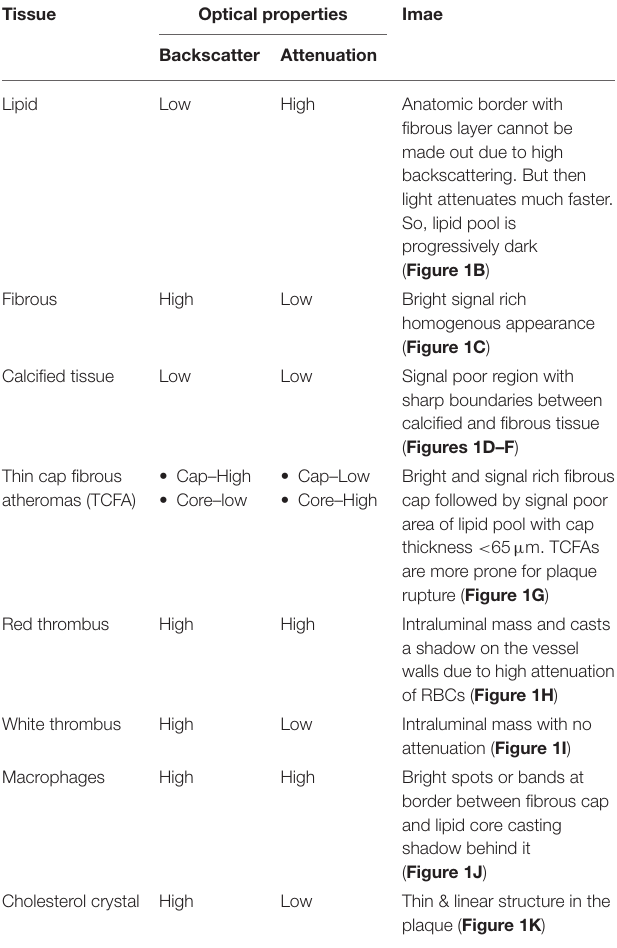
TABLE 4 | Showing optical properties and OCT image interpretation of various atherosclerotic plaque morphologies.